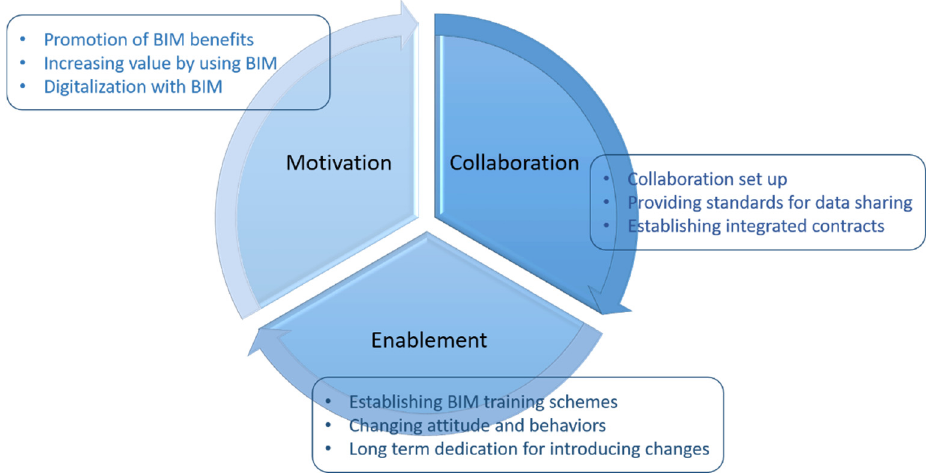
Figure 1. Fields of action toward BIM adoption (adopted by WEF)